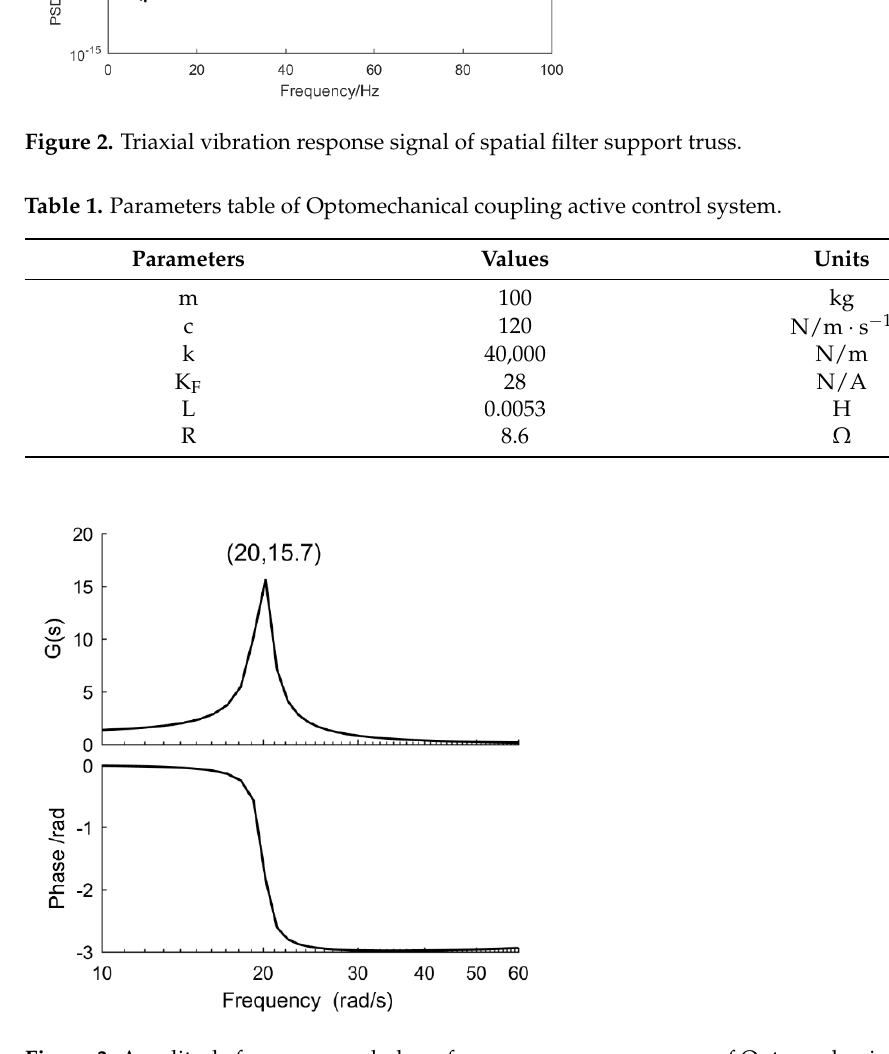
Figure 3. Amplitude frequency and phase frequency response curves of Optomechanical